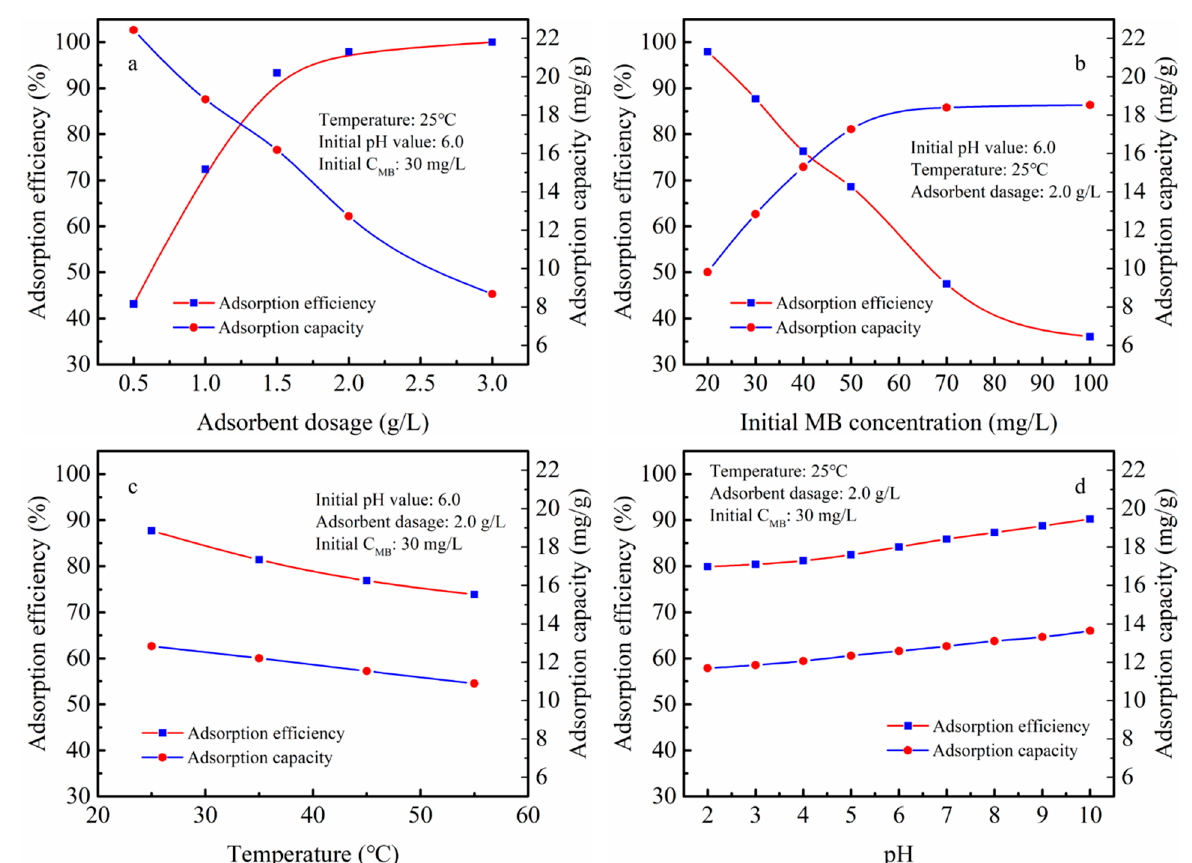
Figure 3. The ( a ) adsorbent dosages, ( b ) initial MB concentrations, ( c ) temperatures, and ( d ) effect of the initial pH values on the adsorption of MB.